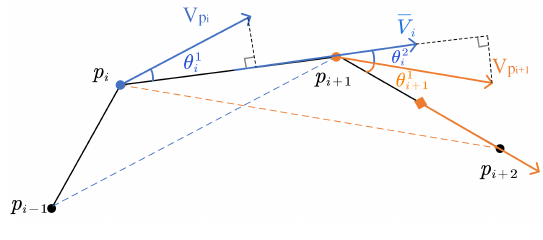
Figure 5. Motion features of a segment.